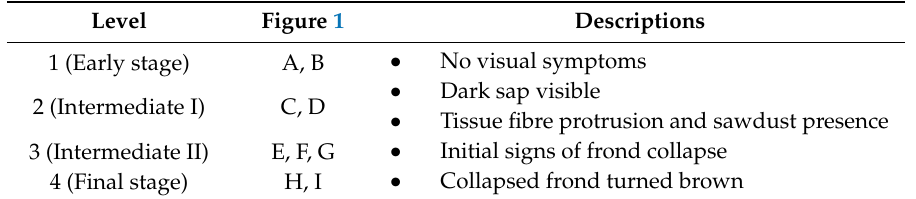
Table 1. Classification of red palm weevil (RPW) infestation level in E. guineensis plantlings. Level Figure 1 Descriptions